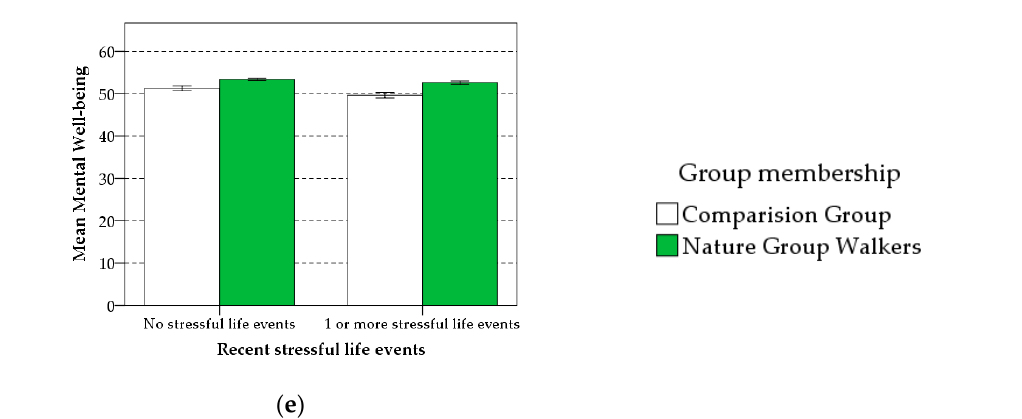
Figure 3. Mean perceived stress ( a ), depression ( b ), negative affect ( c ), positive affect ( d ), and mental well-being ( e ) as a function of recent stressful life events and nature group walk participation. Main sample ( n = 1506). Error bars are ±1 SE of the mean.